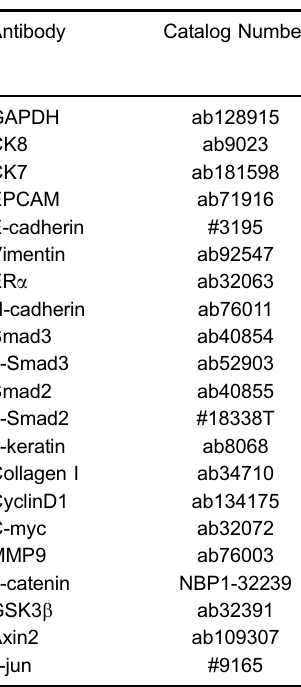
Table 2. Antibodies used in this